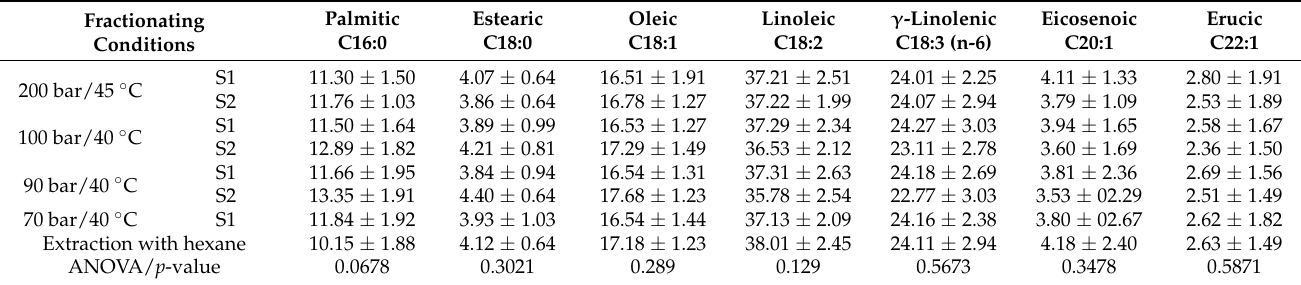
Table 3. Composition of the fatty acids (%) in the different fractions obtained into the different separators (S1: separator 1 and S2: separator 2). Data are represented as the mean with 95% confidence